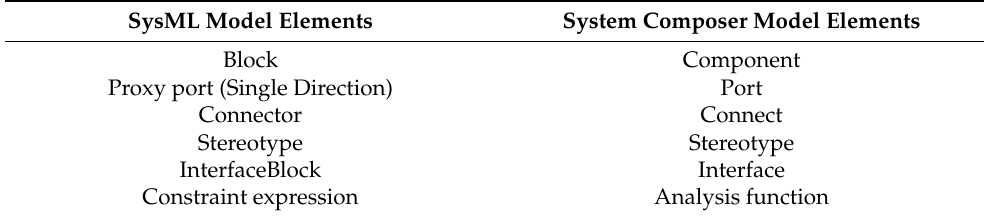
Table 3. Mapping relationship between SysML and System Composer.